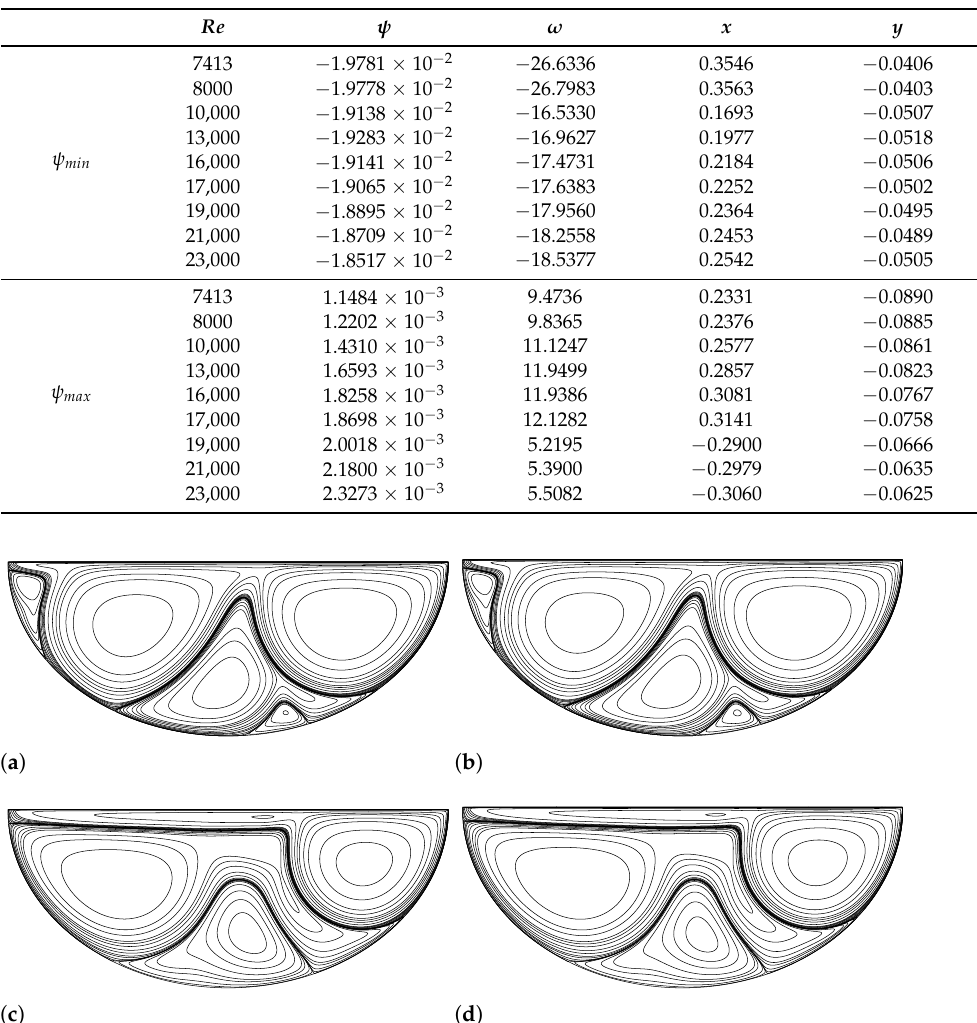
Table 6. Minimum and maximum streamfunction values in the 2nd solution, corresponding vorticity values and ( x , y ) locations for D = 0.26 aspect ratio.